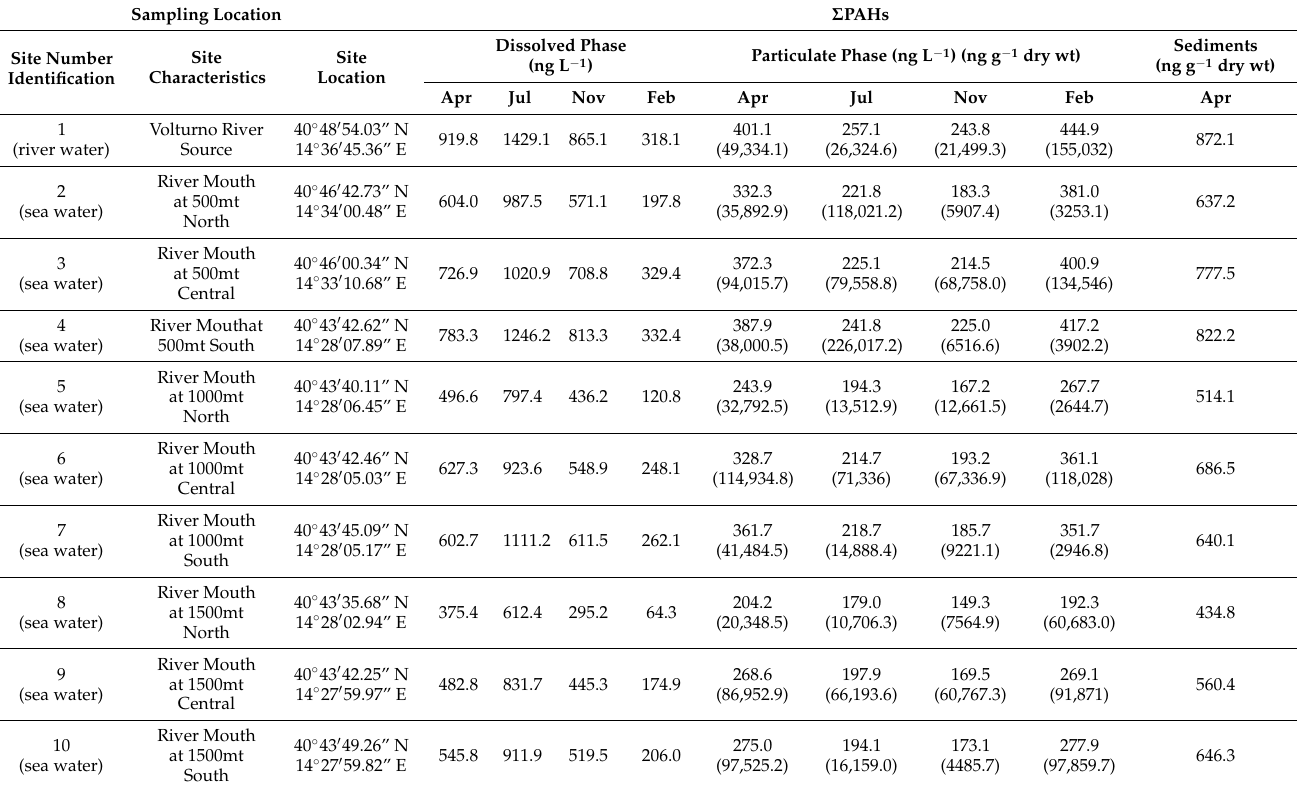
Table 1. Description of the sampling sites and concentration of polycyclic aromatic hydrocarbons (PAHs) in the water dissolved phase (DP), suspended particulate matter (SPM), and the sediments of the Volturno River, Southern Italy. Sampling Location Σ